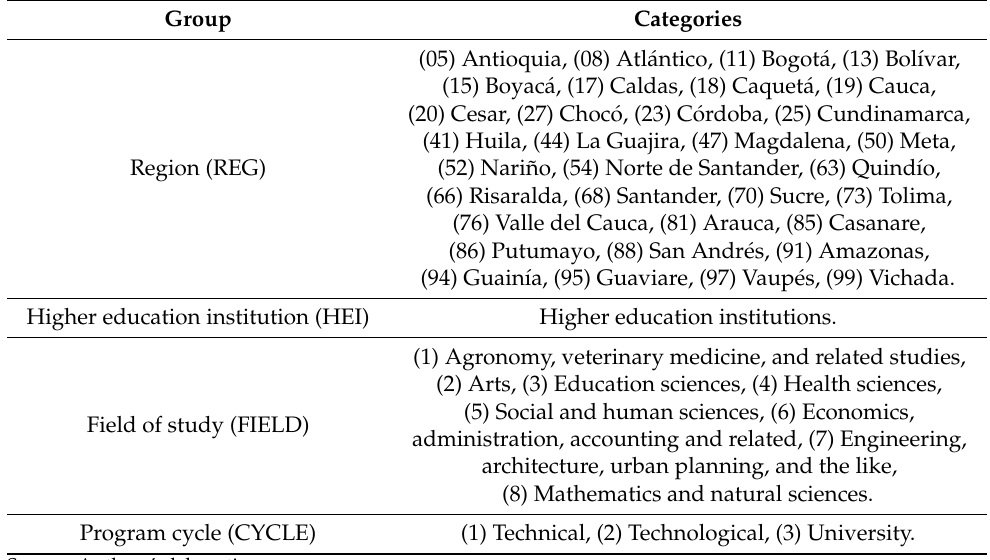
Table 2. Hierarchical model